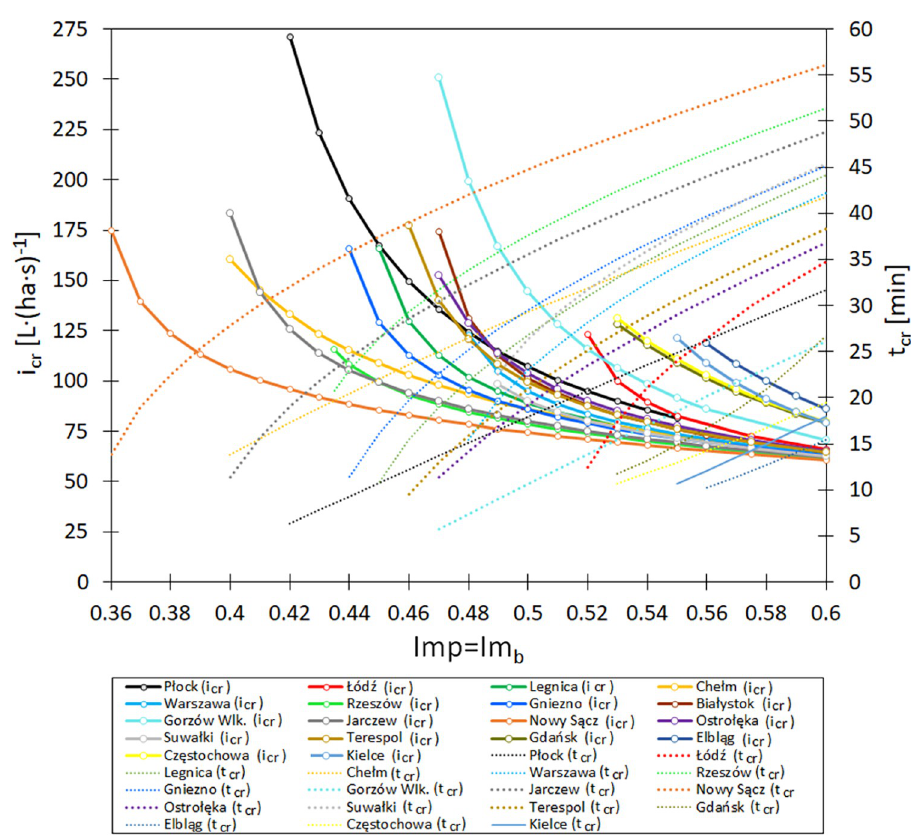
Fig 6. Influence of catchment imperviousness on the rainfall duration (t cr ) and critical rainfall intensity (i cr ) in selected Polish cities.